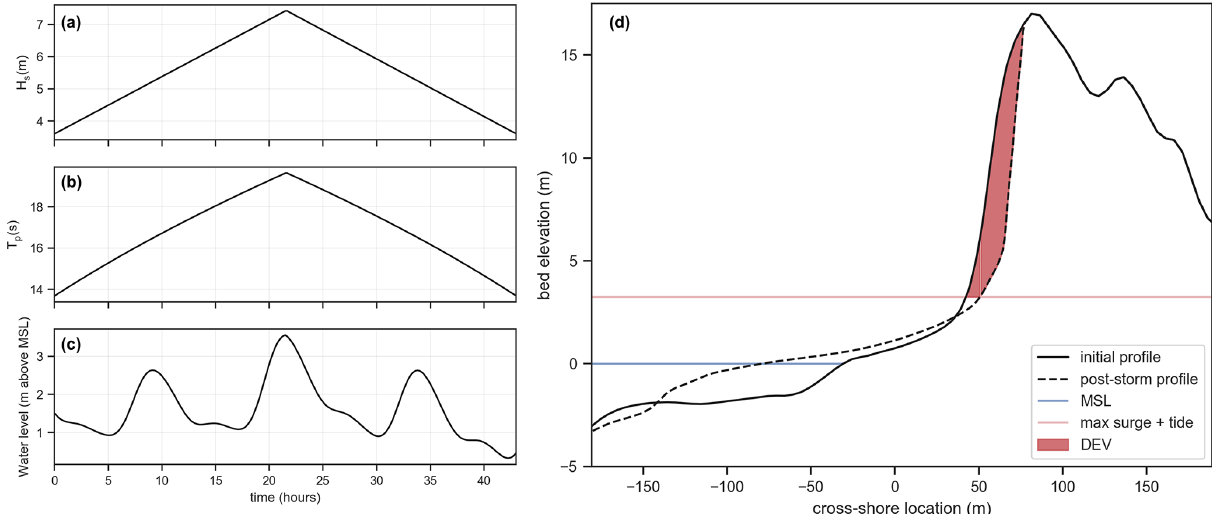
Figure 4. Example of XBeach offshore boundary conditions and dune impact for one selected storm and TCP. (a) H s time series, (b) T p time series and (c) water level time series at offshore boundary. (d) Post-storm simulated profile and calculation of dune erosion volume